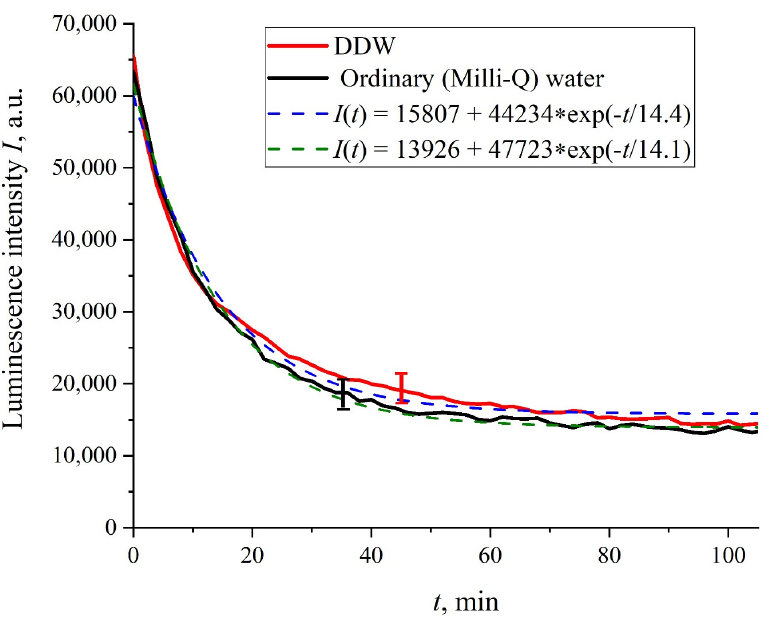
Figure 2. Intensity of luminescence I ( t ) vs. the soaking time in ordinary water and DDW in the absence of NaCl and amino-acids.